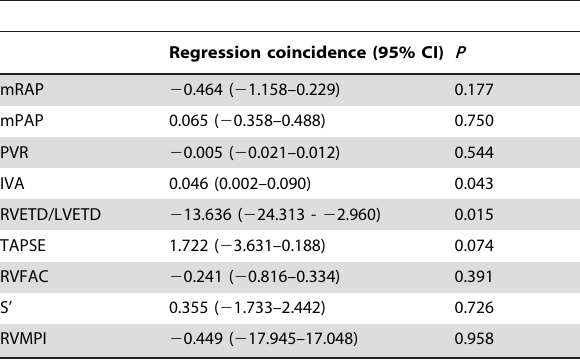
acceleration; RVETD/LVETD, ratio of right ventricular transverse diameter to left ventricular transverse diameter; TAPSE, tricuspid annual plane